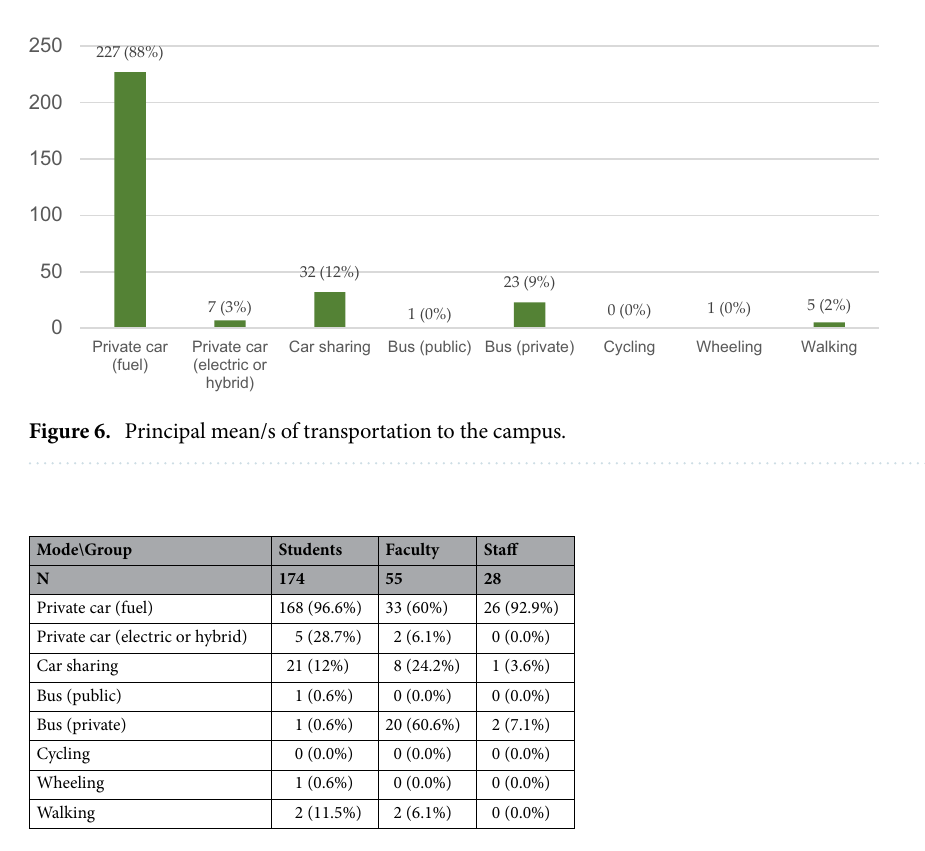
Table 4. Principal transportation modes used to travel to the